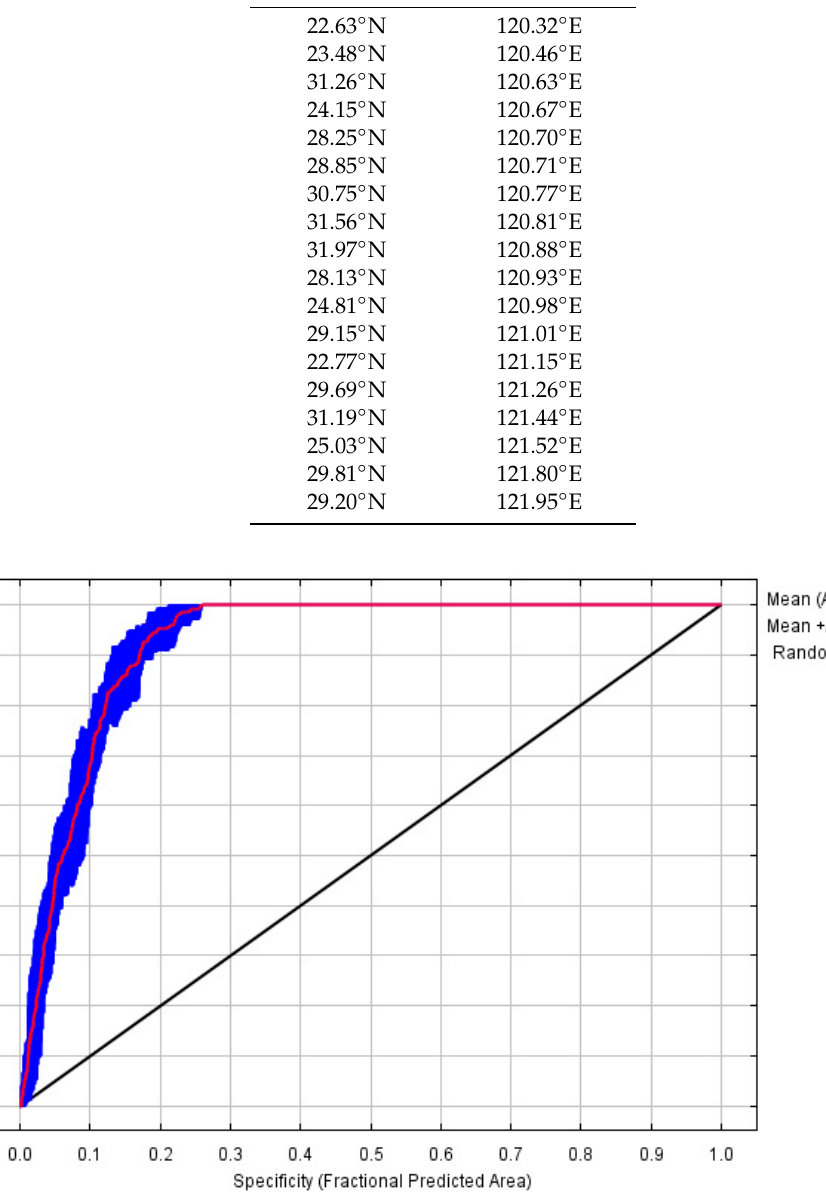
Figure A1. This picture is the receiver operating characteristic (ROC) curve of the camphor tree habitat distribution model. The red curves shown are the averages over 10 replicate runs. The average test AUC for the replicate runs is 0.923, and the standard deviation is 0.010.